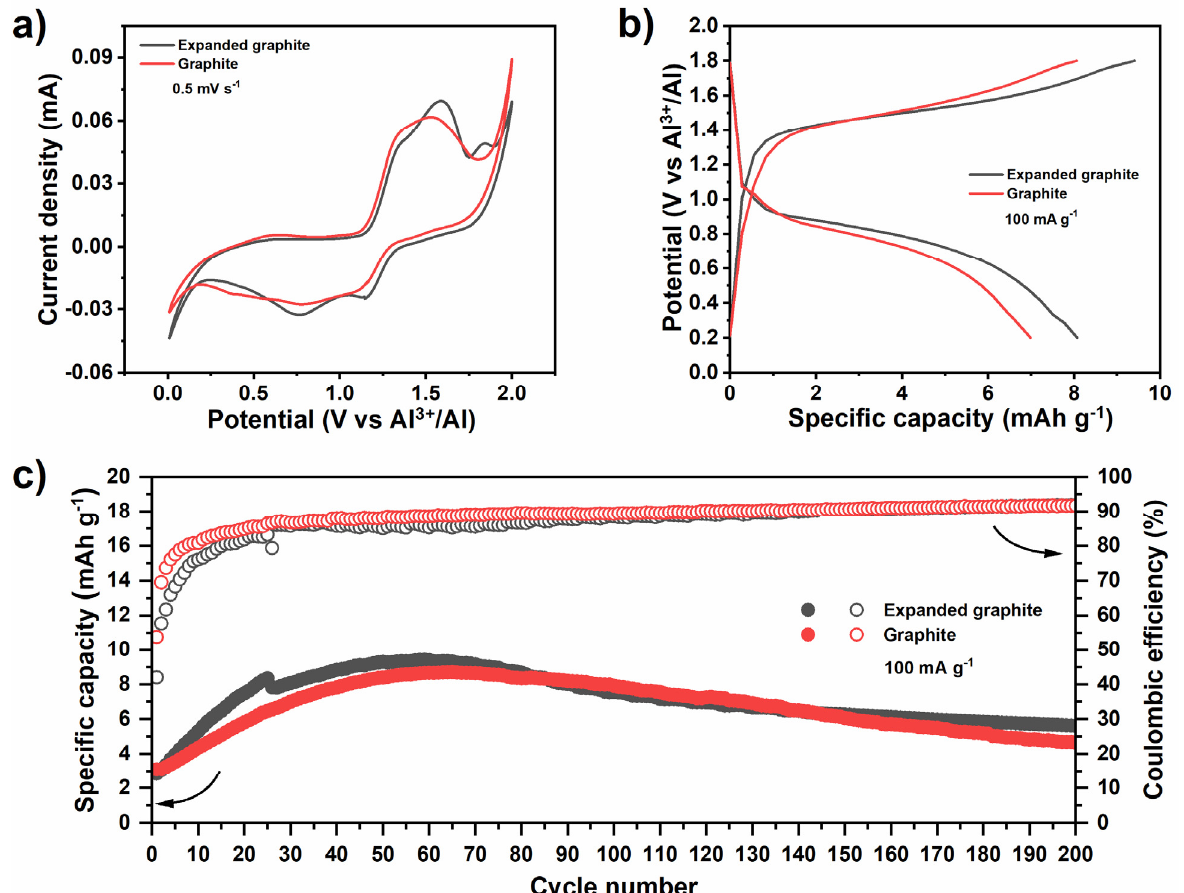
Figure 3 . Electrochemical performance of the graphite and expanded graphite cathode: ( a ) cyclic voltammetry, ( b ) charge − discharge voltage profiles and ( c ) cycling stability with Coulombic efficiency.